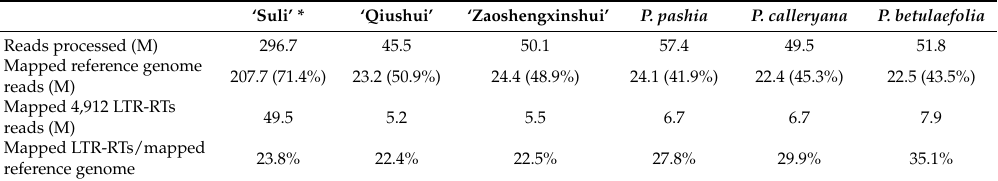
Table 1. The number of processed reads and mapped reads in this study. ‘Suli’